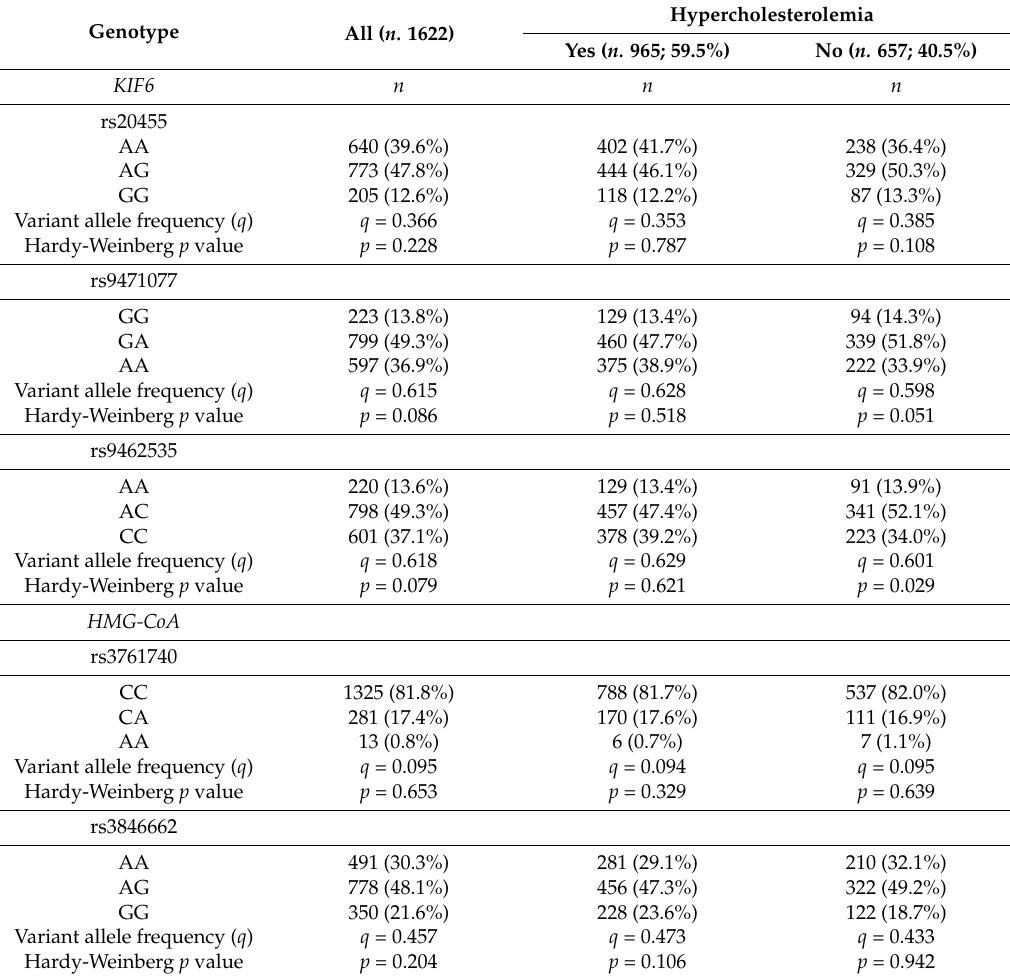
Table 2. KIF6 and HMG-CoA genotypes distribution in the studied population